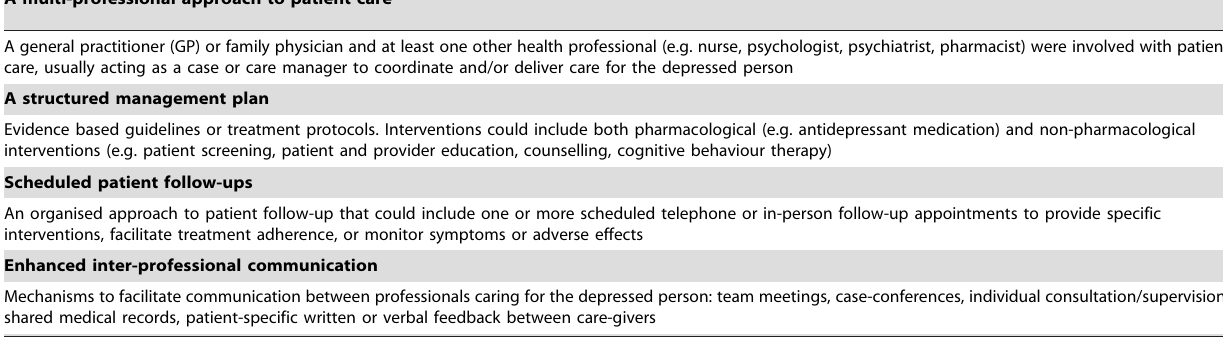
Table 1. Key characteristics of collaborative